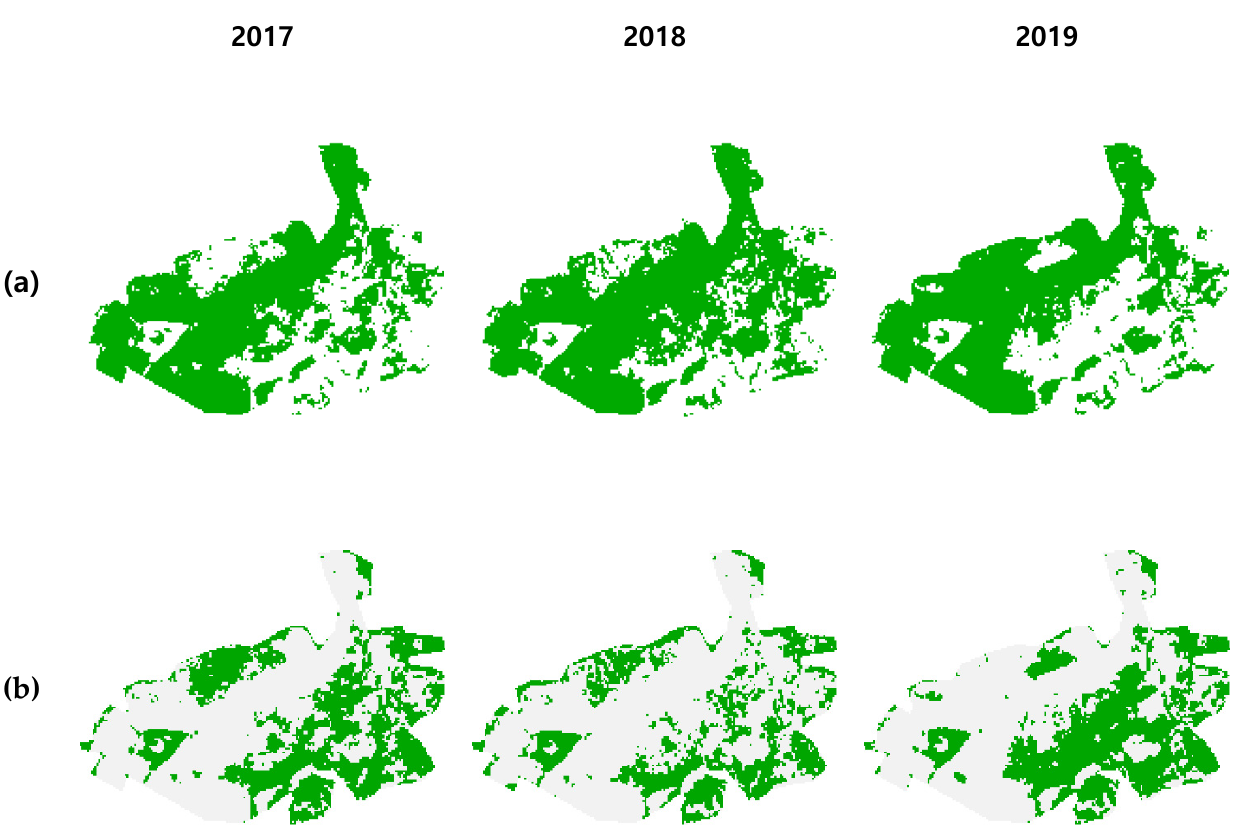
Figure 5. Vegetation classification image on Geomunoreum forest from 2017 to 2019. ( a ) Evergreen (NDVI values > 0.6); ( b ) deciduous (0.6 ≥ NDVI values) .